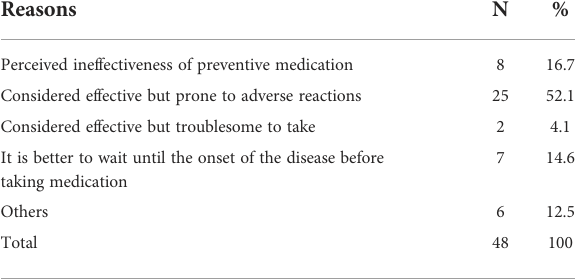
TABLE 4 Analysis of the reasons why health care workers think preventive medicine is unnecessary.